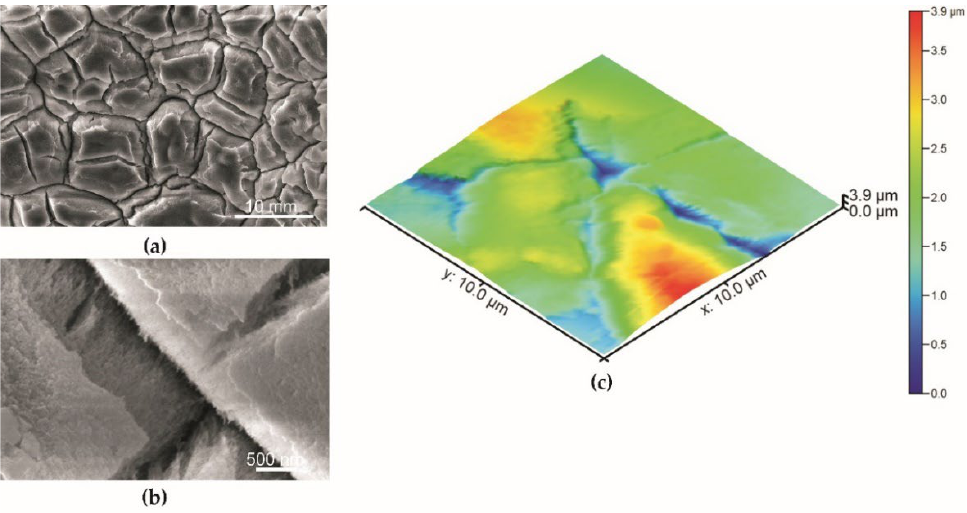
Figure 5. The surface of the specimen from Series 2 before impregnation by PDMS: ( a ) mag. 10,000×; ( b ) mag. 100,000×; ( c ) AFM topography.